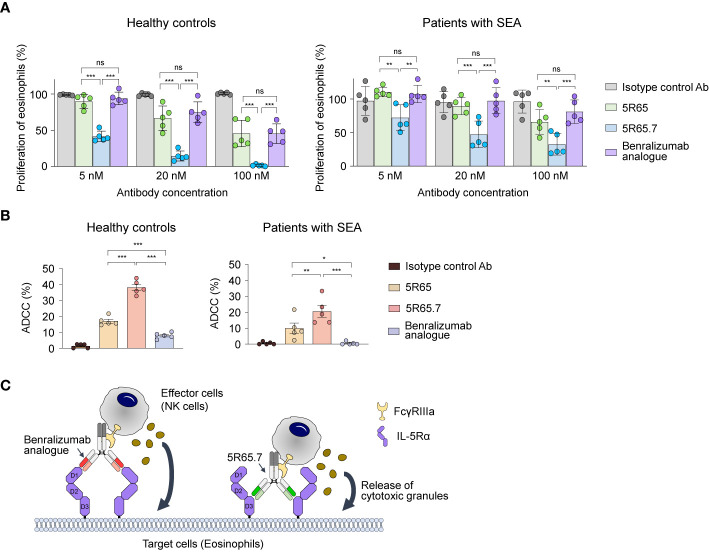
Functional activity of the anti–IL-5Rα Abs against eosinophils from healthy donors and patients with SEA. (A) IL-5Rα–blocking activity of the indicated Abs, as evidenced by the influence on the proliferation of eosinophils from healthy controls and patients with SEA after stimulation with rhIL-5 (100 pM) in the presence of Abs (5, 20, or 100 nM) for 40 h. Data are presented as a percentage (mean ± SD, n = 2 or 3) after normalization to the vehicle control (100%). (B) The indicated anti–IL-5Rα Ab-mediated ADCC against eosinophils from healthy controls and patients with SEA. Eosinophils were cocultured with NK cells purified from autologous PBMCs at a 1:5 ratio of target cells to effector cells in the presence of rhIL-5 (100 pM) and the indicated Abs (1 μM) for 20 h. Each circle represents a value obtained from an individual donor. Data are presented as percentages (mean ± SD, n = 5). Statistical analysis was performed via one-way ANOVA followed by the Newman–Keuls post hoc test. *P < 0.05; **P < 0.01; ***P < 0.001 and ns, not significant between the indicated groups. (C) A schematic diagram illustrating the difference in ADCC potency between the benralizumab analogue and the 5R65.7 Ab. The benralizumab analogue and 5R65.7 bind to membrane-distal domain D1 and membrane-proximal domain D3 of IL-5Rα, respectively, thereby yielding a corresponding wide or tight cytolytic synapse between an effector NK cell and a target eosinophil.